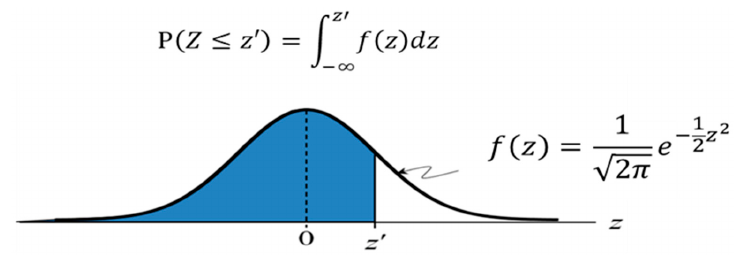
Figure 7. Cumulative distribution function example.